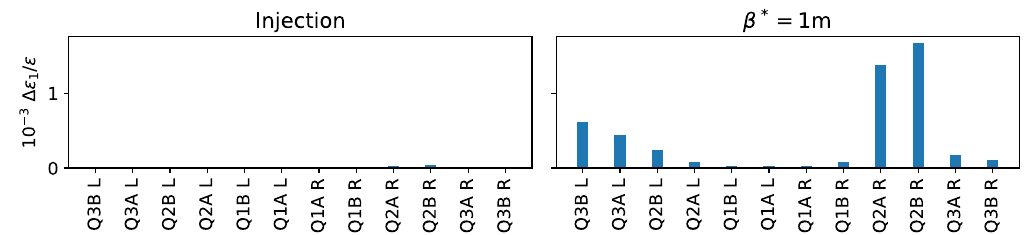
FIG. 7. Relative emittance growth produced by one-turn relative change of 0 . 3 × 10 − 4 in the magnetic field of the quadrupoles of the HL-LHC triplet at injection (left) and 1 m optics (right) optics. The values follow the expected dependency on orbit and β -function.